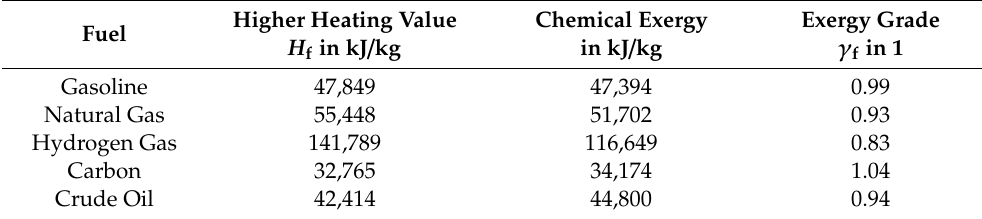
Table 2. Exergy grades for selected fuels at 25 ◦ C and p 0 = 1.01325 bar [7,8,12].